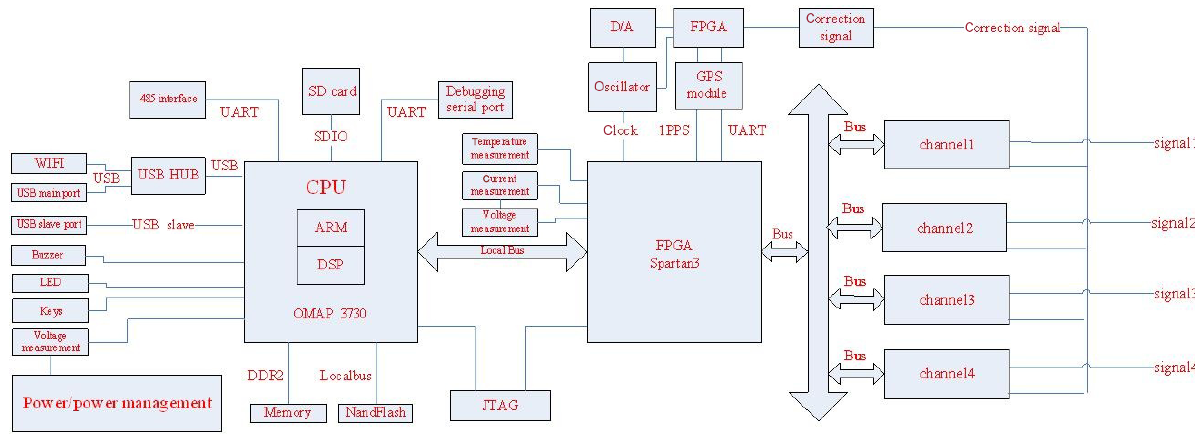
Figure 4. Block diagram of the hardware design for the main control circuit of the wireless microseismic acquisition station.